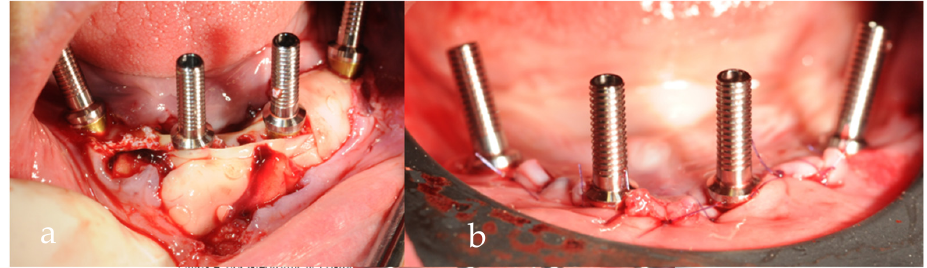
Figure 15. ( a ) Detail of the L-Prf membranes and ( b ) suturing of the flap with 5/0 Polyglycolic Acid Sutures.